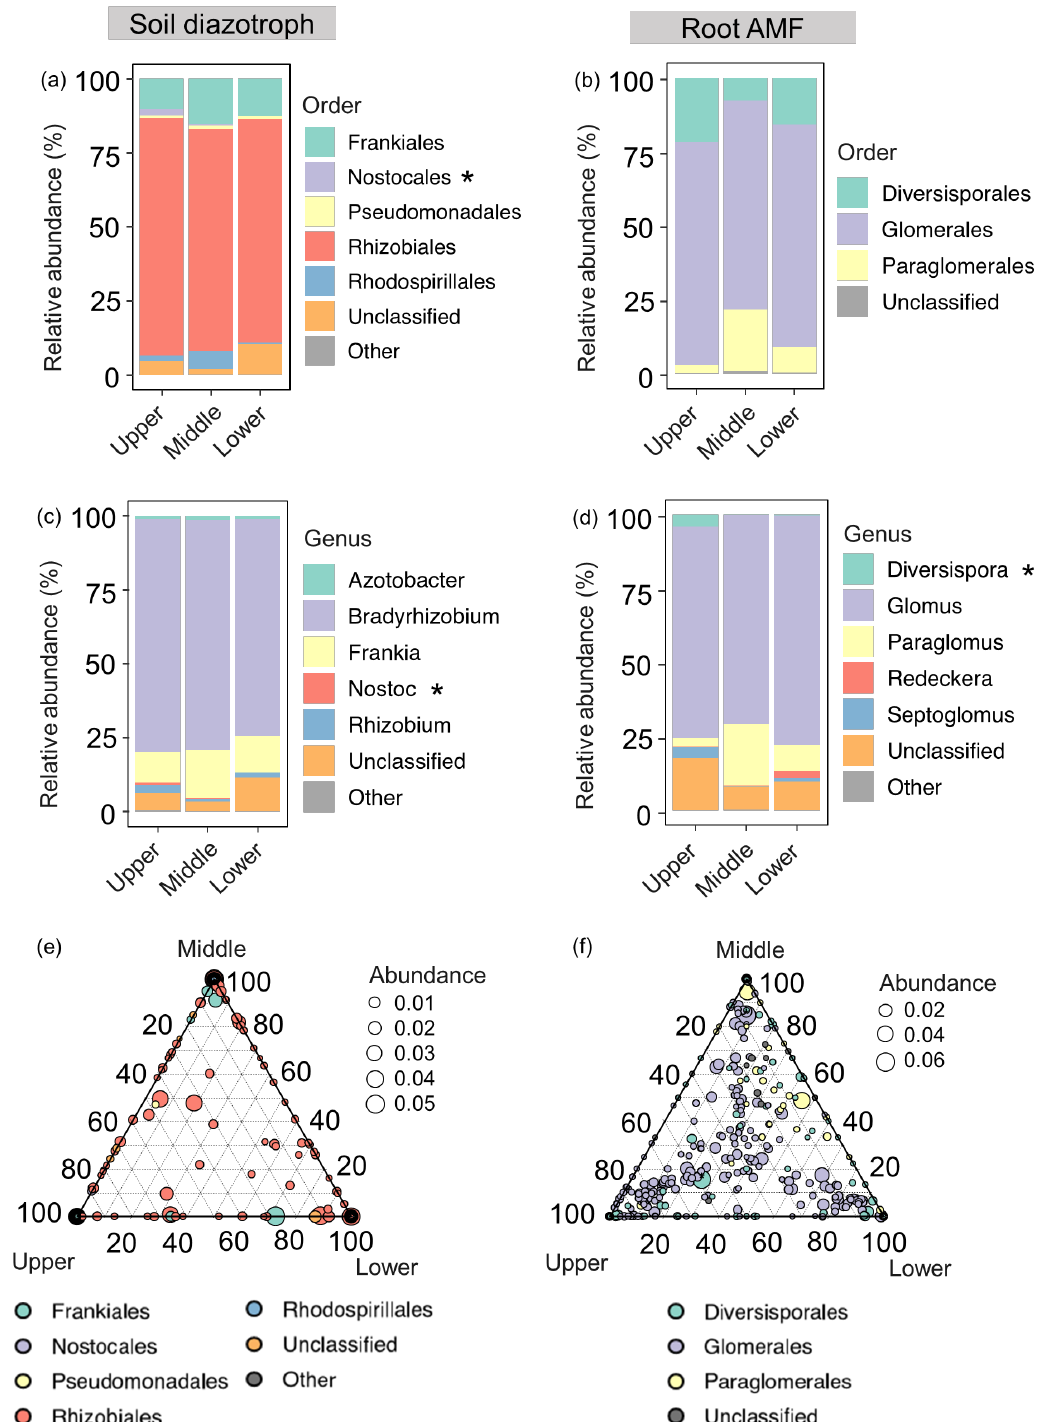
Figure 3. Soil diazotroph and root AMF community composition among slope positions. The relative abundance of the taxa at the levels of order ( a , b ) and genus ( c , d ). The asterisk “*” in the ( a , c , d ) denotes the significant difference among upper, middle, and lower slope positions. The ternary plots of all ASVs detected in soil diazotroph and root AMF ( e , f ); each circle represents one ASV, and the circle size indicates the relative abundance. The position of ASVs according to three axes were determined by the contribution of three slope positions to the total relative abundance and proximity to that vertex, indicating enrichment of that ASV in the slope position.